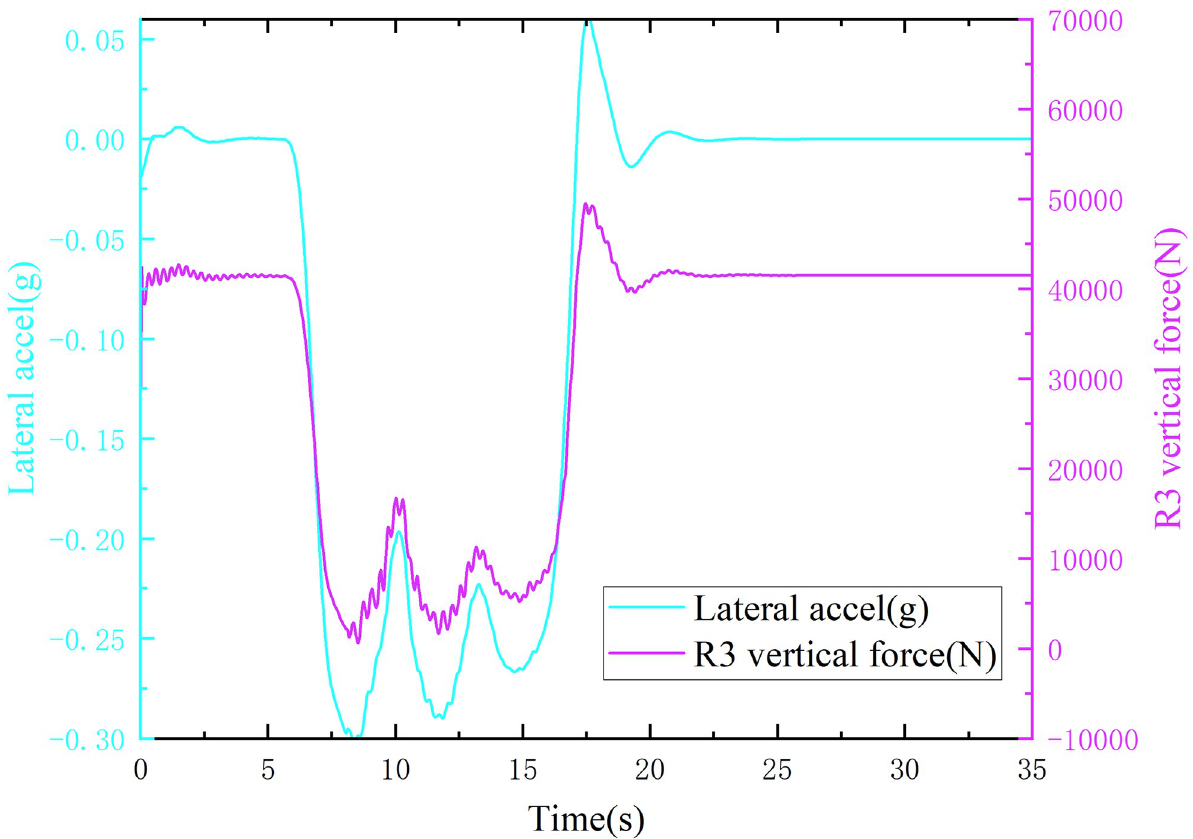
Fig 12. Lateral acceleration, right wheel vertical force curve (adhesion coefficient